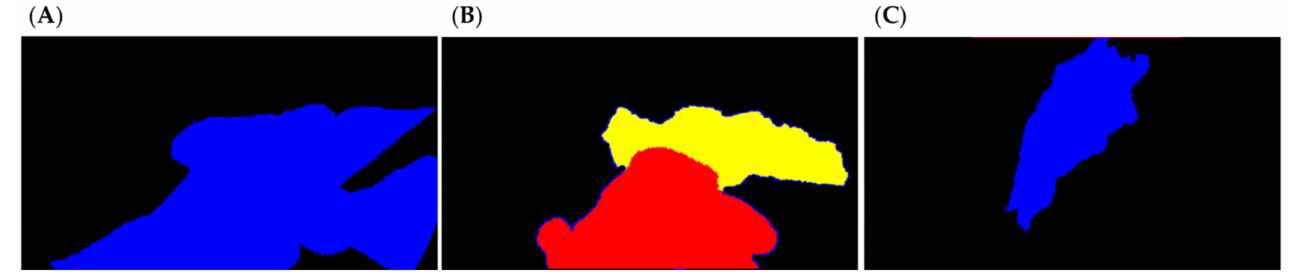
Figure 2. Colored multiclass masks of frames from Figure 1. Type I ( A ); type II ( B ); type III ( C ). To better distinguish, the proximal part is colored in red, the distal part is colored in yellow, and the total part is colored in